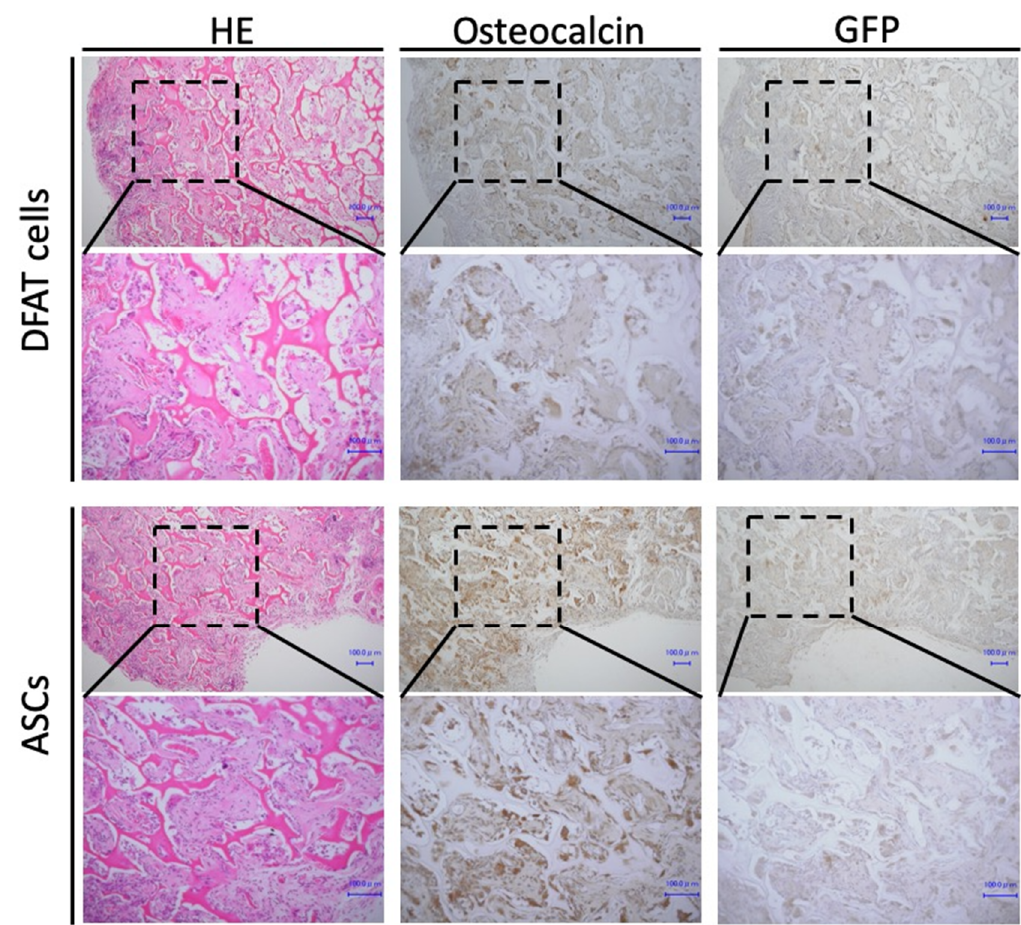
Figure 5. Ectopic bone formation analysis. Hematoxylin and eosin (H&E) stained images of ectopic bone formation at 4 weeks in DFATs group and ASCs group. Scale bar = 100 μm.